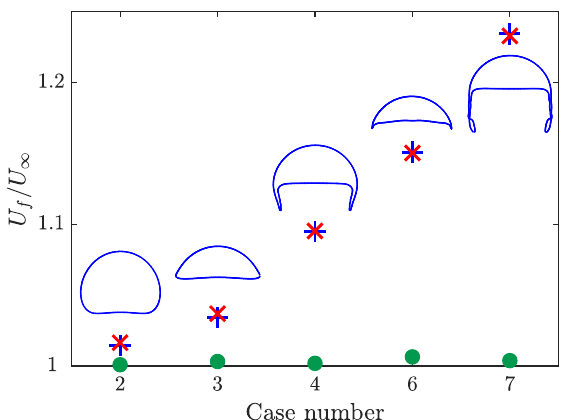
Figure 7. Comparison of the bubble velocity at the top of the domain U f normalized by the non-reactive terminal velocity U ∞ for simulations with one volume conserving species (green dot), one non-volume conserving species (blue cross), and both a volume and non-volume conserving species (red x). The steady-state bubble shape from the non-reactive simulation is presented for each case with the proper aspect ratio but not at the same